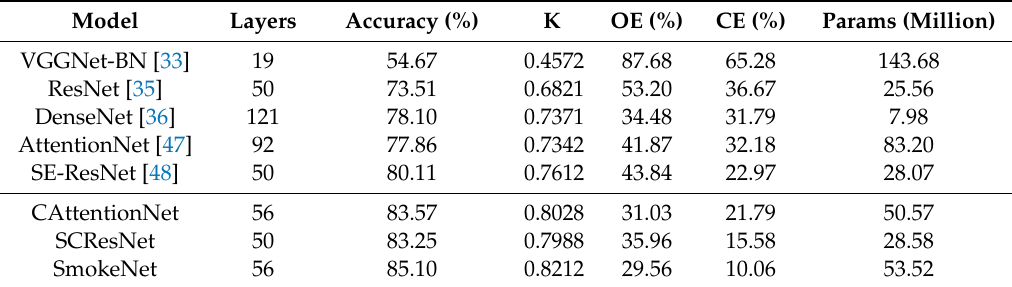
Figure 4. Classification results of the state-of-the-art models (VggNet19-BN, ResNet50, DenseNet121, SE-ResNet50, and AttentionNet92), the combined models (CAttentionNet56 and SCResNet50), and the proposed SmokeNet56 trained with four proportions (16%, 32%, 48%, and 64%) of training images. ( a ) Testing accuracy; ( b ) Kappa coefficient; ( c ) omission error (OE) of the smoke class; ( d ) commission error (CE) of the smoke class. Table 6. Classification results of the eight models trained with 16% training images and the number of model